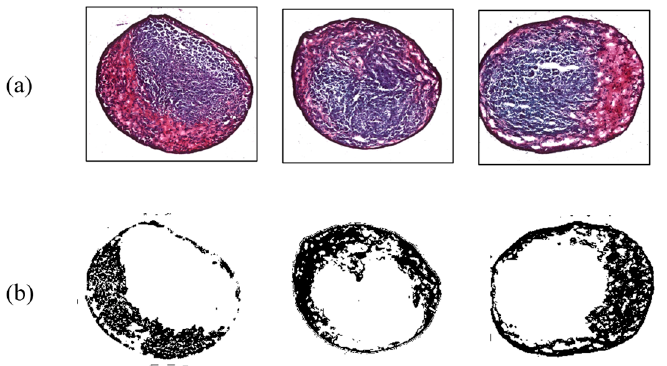
Figure 7. Chondrogenesis results for the control group. ( a ) Safranin-O-stained MSCs; ( b ) chondro- genic portion identified by ImageJ.